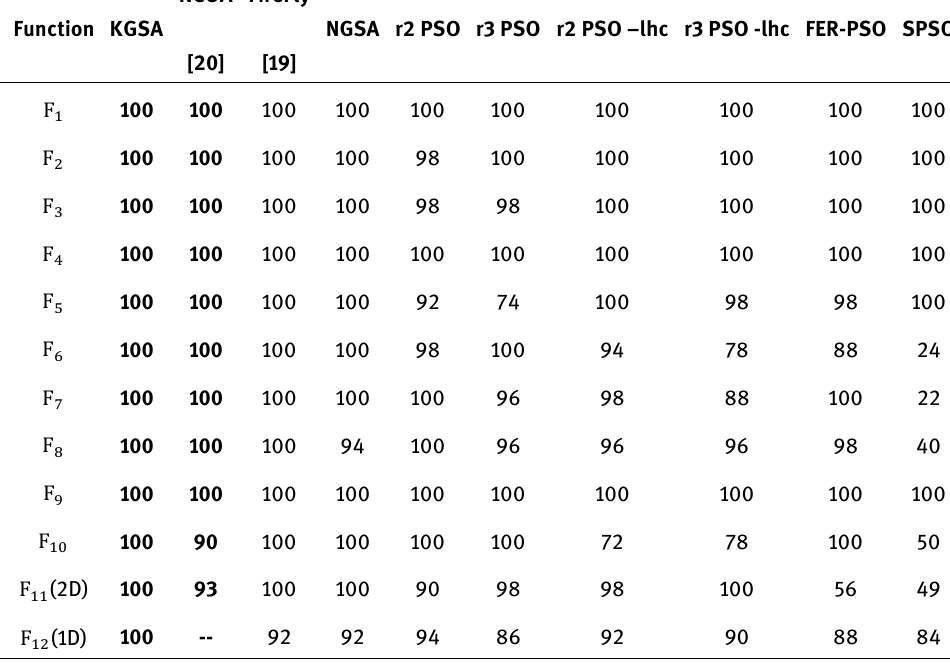
Table 1: Comparison of found global maximum (%ADR) obtained with KGSA, NGSA, r2PSO, r3PSO, r2PSO-lhc, r3PSO-lhc, FER- PSO and SPSO using functions F 1 to F 12 . The results were averaged after fifty independent runs of algorithms.